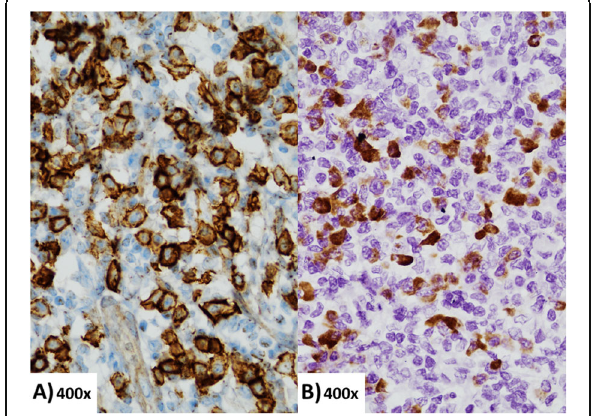
Fig. 4 a CD138 immunostain highlights the plasma cells and b IgG4 immunostain highlights the subset of CD138 plasma cells which are IgG4 positive. The overall there were > 100 IgG4 positive plasma cells/HPF and the ratio of CD138:IgG4 was >